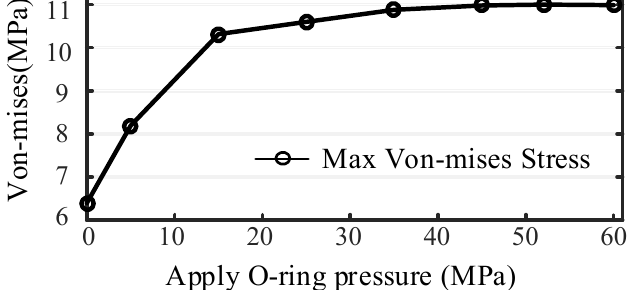
Figure 12. Equivalent stress of O-ring affected by fluid pressure.